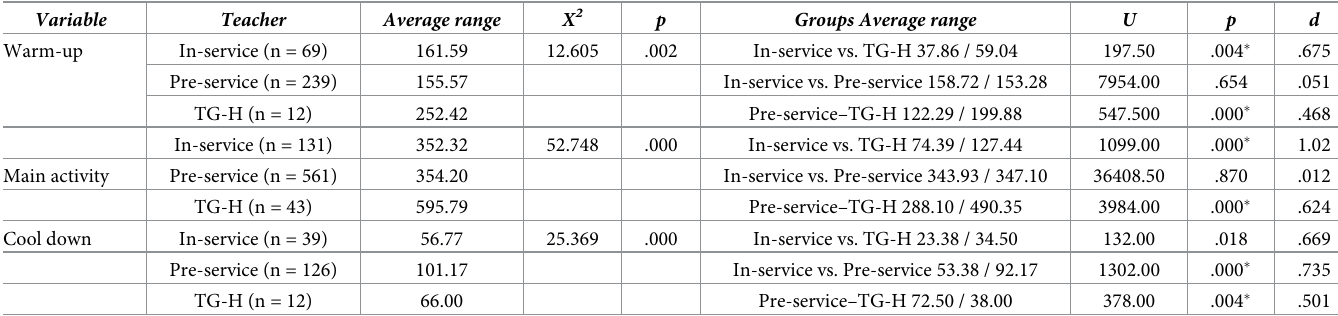
Table 5. Inferential analysis of eTL according to the